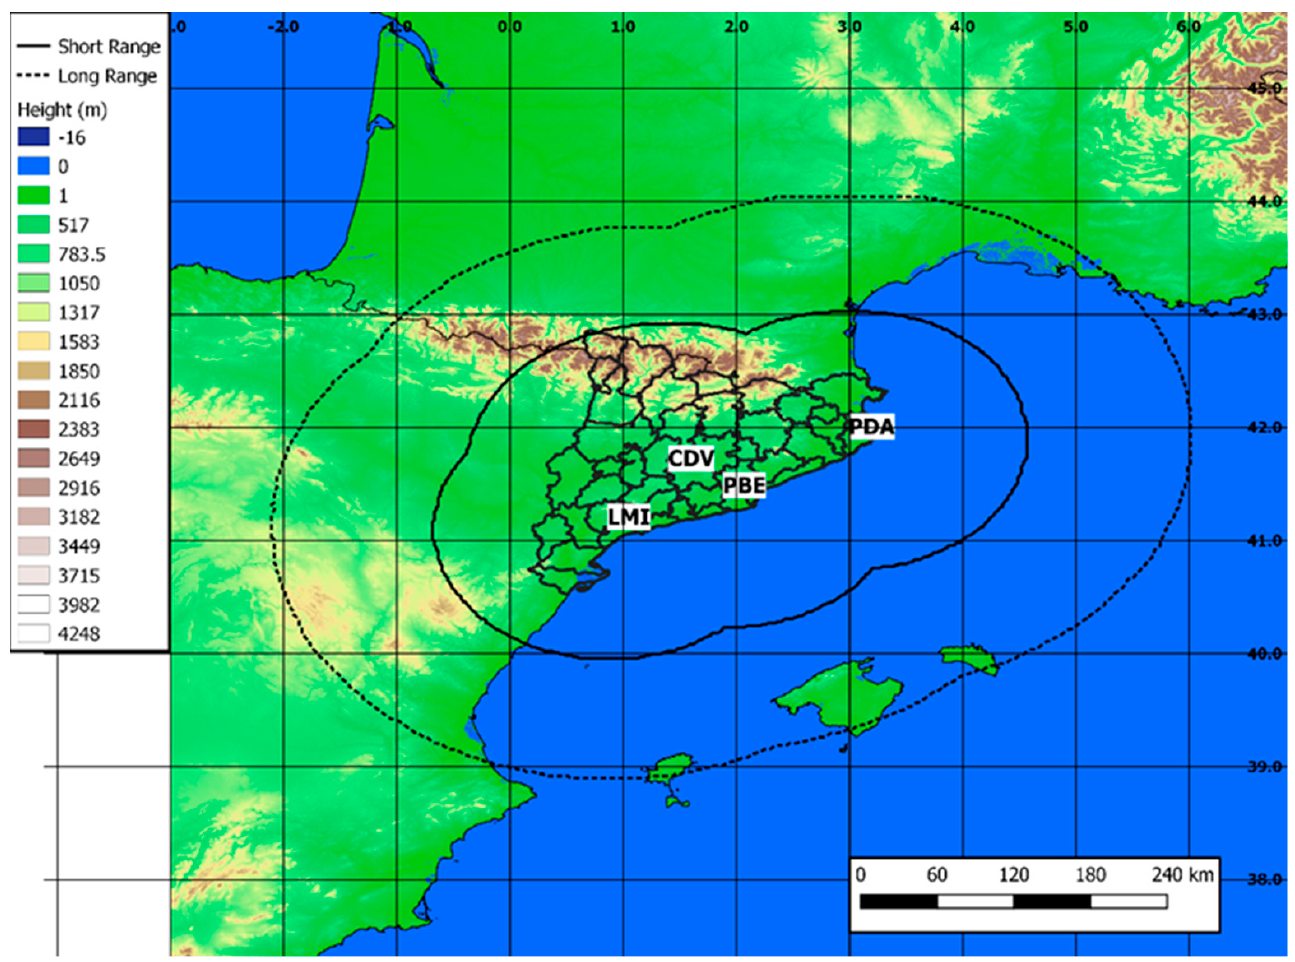
Figure 1. Area of study and the radars of the Servei Meteorologic de Catalunya. The solid and dashed lines indicate the short and long ranges, respectively (see text for more details).